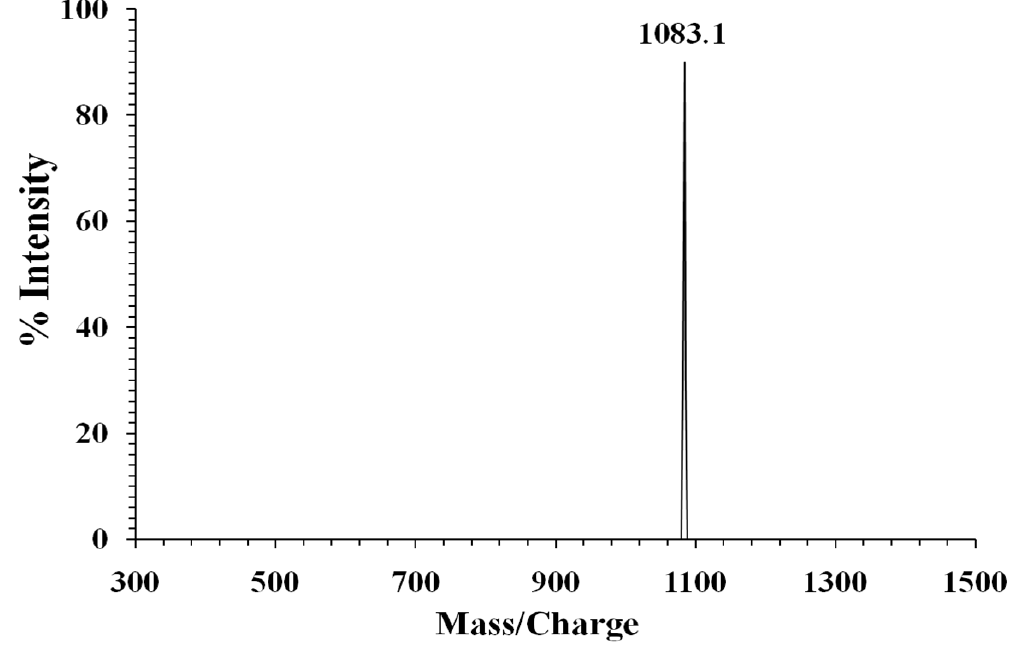
Figure 3. Mass spectrum of Potide-J.